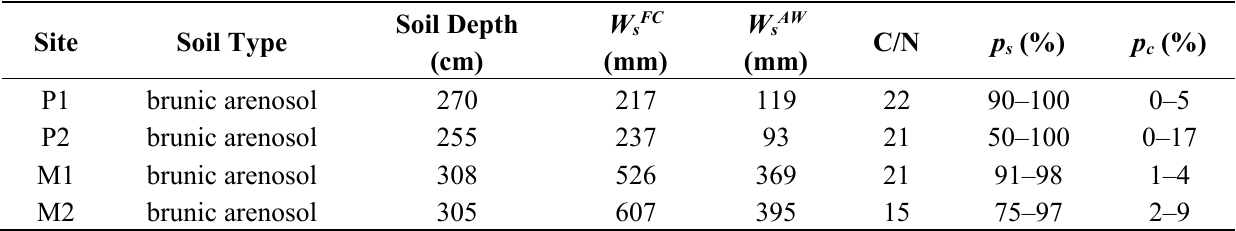
Table 2. Soil characteristics from soil inventory ( W s FC = Sum field capacity, W s AW = Plant available water at maximum rooting depth, C/N = Carbon Nitrogen ratio total soil, p s = range sand fraction, p c = range clay